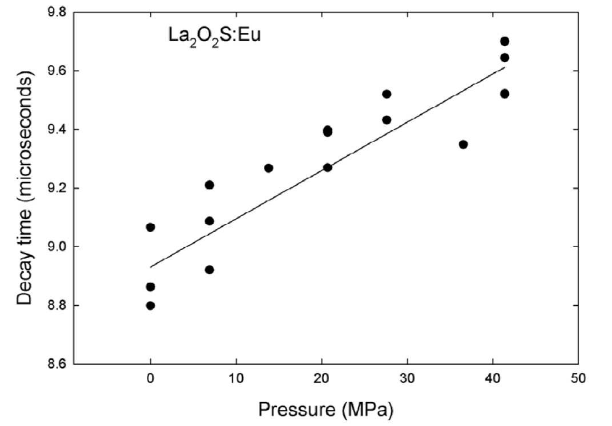
O S:Eu phosphor with increasing pressure 2 2